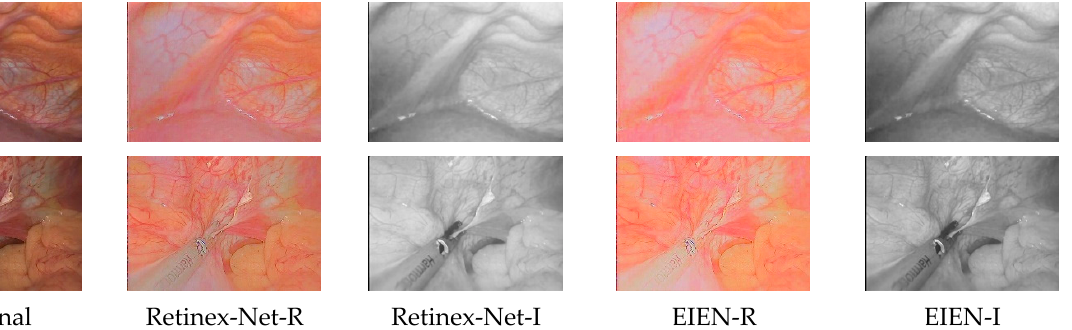
Figure 11. The initial decomposition results and the decomposition results after weight fine-tuning. The second and third columns show the reflectance and illuminance components of the original Retinex-Net decomposition results, respectively. The fourth and fifth columns show the reflectance and illuminance components of the decomposition after fine-tuning the weights.